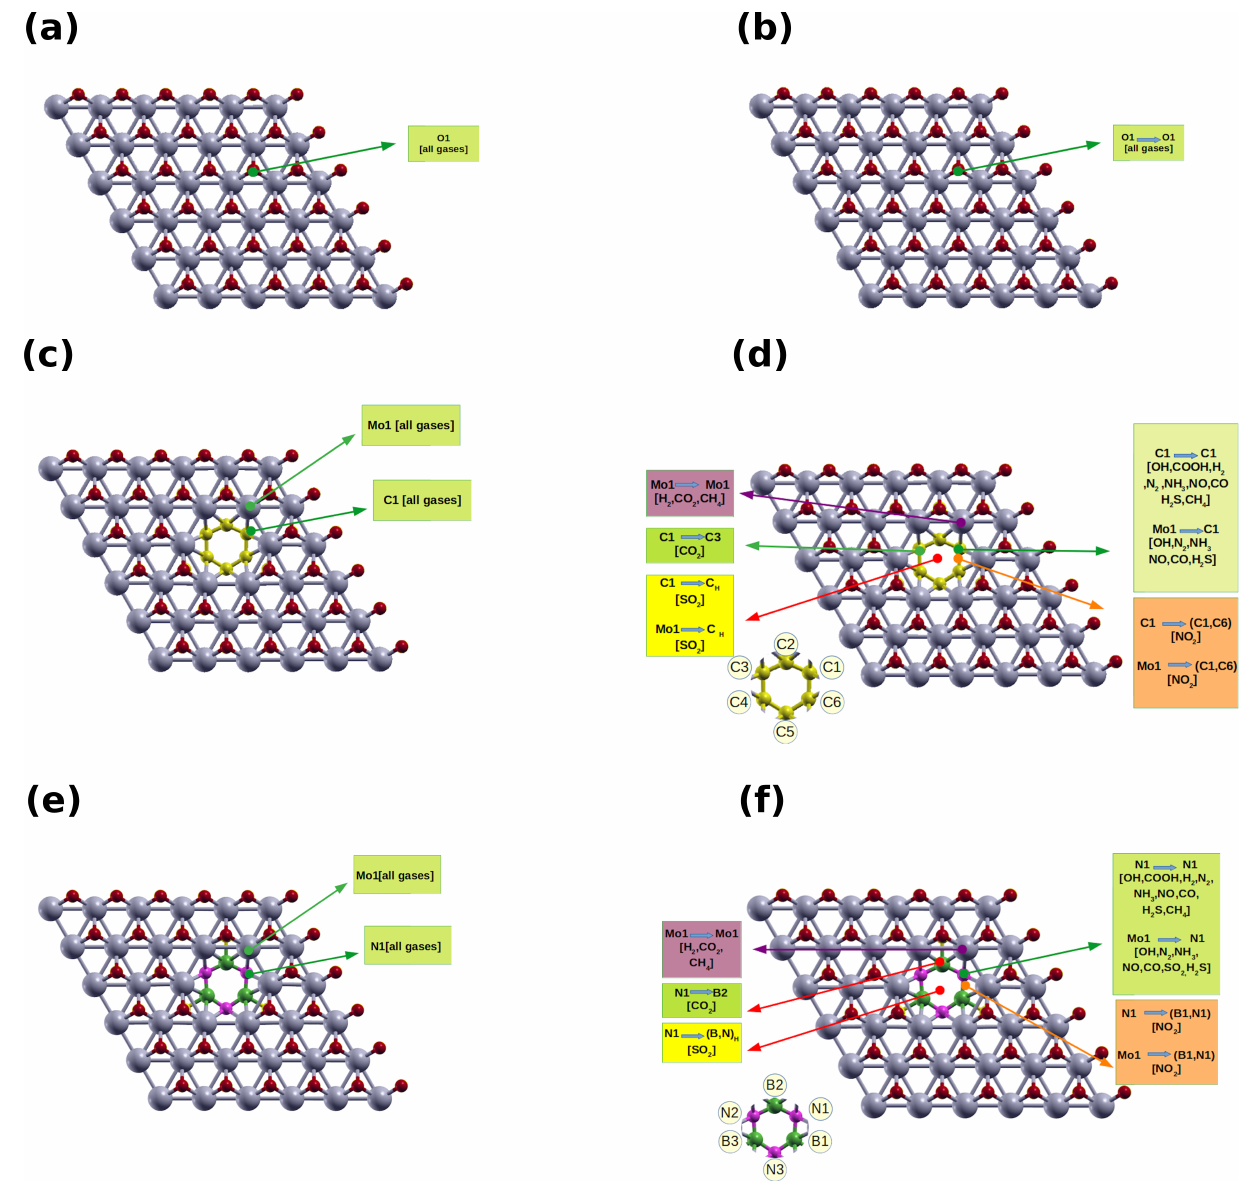
Figure 3. Adsorption locations of various molecules on ( a , b ) pristine M-O1, ( c , d ) G-M-O1, and ( e , f ) BN-M-O1. C H and (B,N) H refer to the center of the patch.Mo, C, O, B, and N atoms are shown in gray, yellow, red, green, and pink,